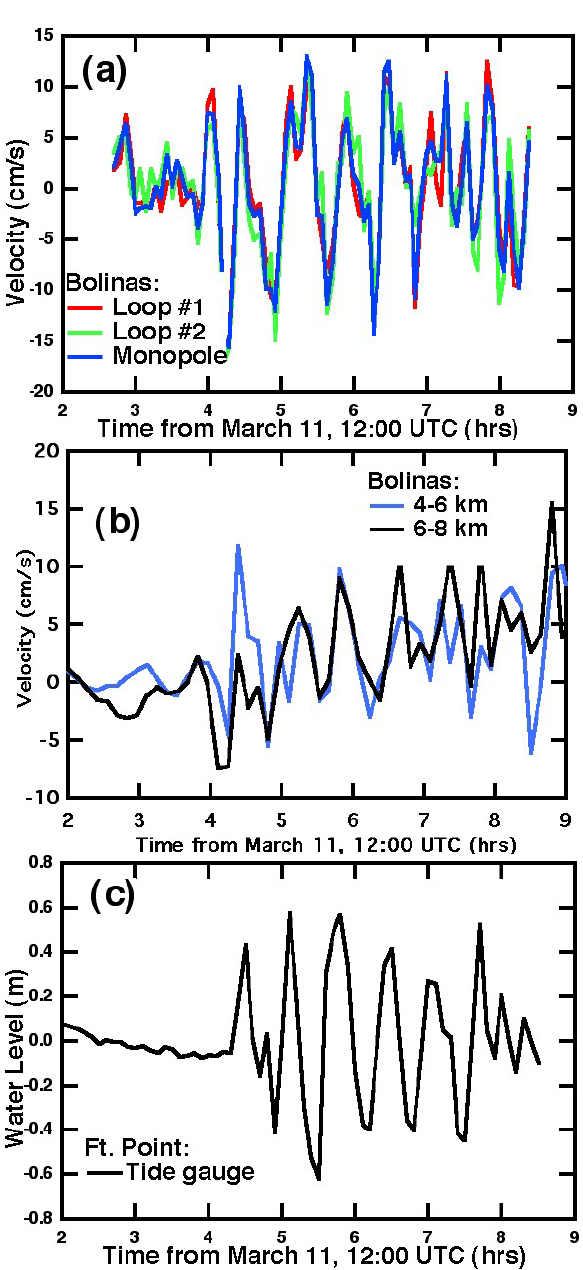
Figure 10. (a) Radial current velocity estimates with long-term trends removed, obtained from the frequency shift of the Bragg peak centroid frequency from the ideal Bragg frequency for three co-located radar antennas near Bolinas, California, (13 MHz transmitter frequency) plotted vs. time; (b) Time series of velocity components from the radar near Bolinas Radial velocities were resolved perpendicular to the shore, and averaged over bands 2 km wide parallel to the shore; (c) Simultaneous tide gauge water level measurements at Fort Point, at the mouth of San Francisco Bay, with long-term trends